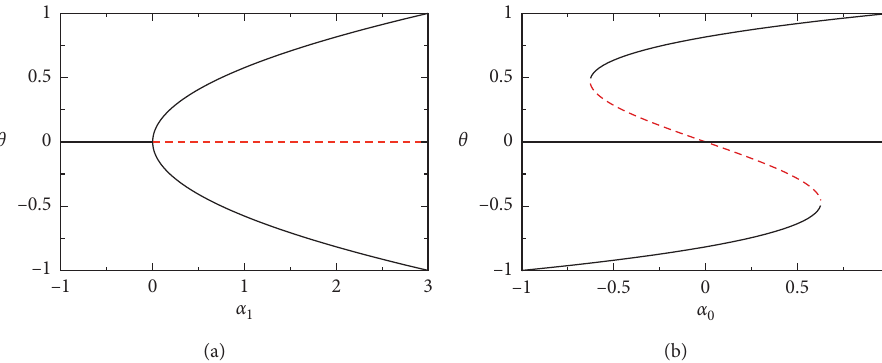
Figure 2: Plot of equation (9) with a given by colored dots. The neutral opinion (red) is an instable solution for α extreme opinions (green) the inverse stability holds.